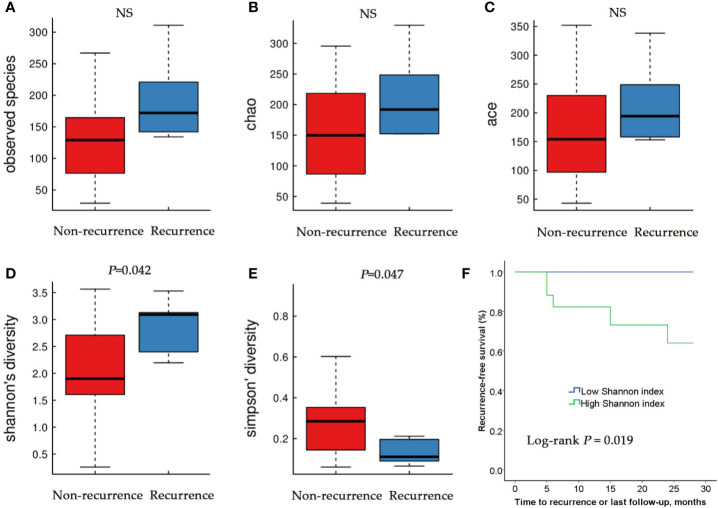
Alpha diversity and Kaplan–Meier analysis for RE patients and NR patients urinary microbiome. Observed species (A); Chao index (B); Ace index (C); Shannon index (D); Simpson index (E). (F) Kaplan-Meier plot of patients with NMIBC defined by alpha diversity.